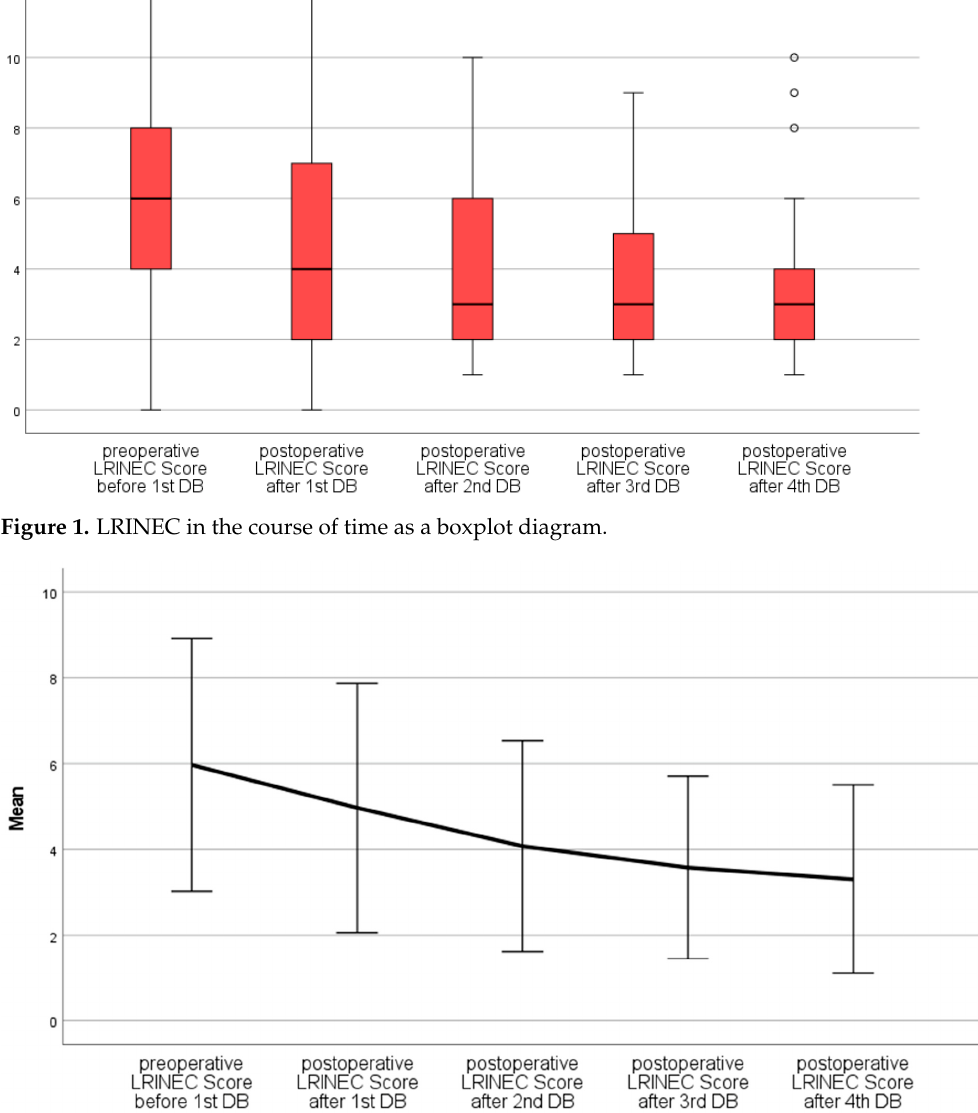
Figure 2. Mean LRINEC in the course of time .